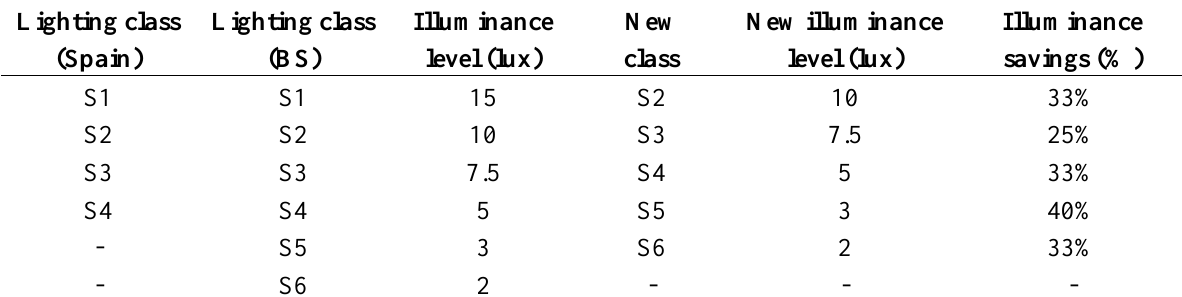
Table 2. Illuminance savings by reducing lighting class.